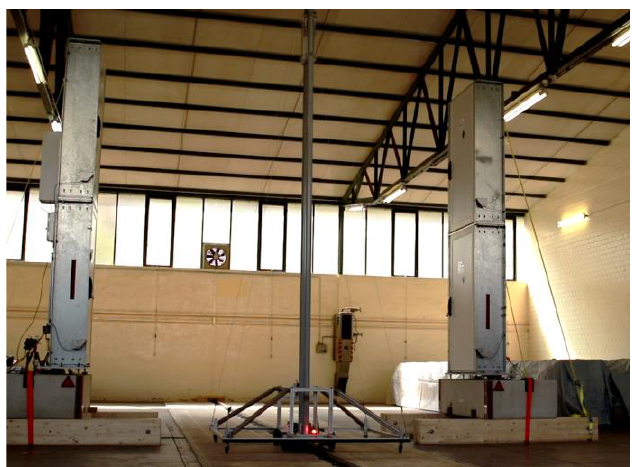
Fig. 3.. Dynamic test system with portal monitor from Arktis.